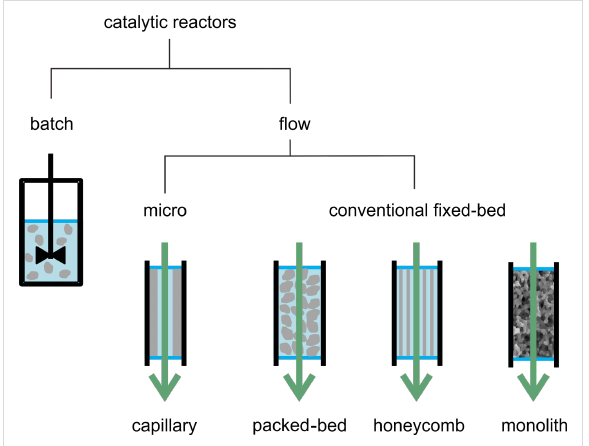
Figure 1: Schematic representation of most common reactor types for batch and continuous-flow partial hydrogenation of alkynes. Particles, layer or body of the catalyst in grey.